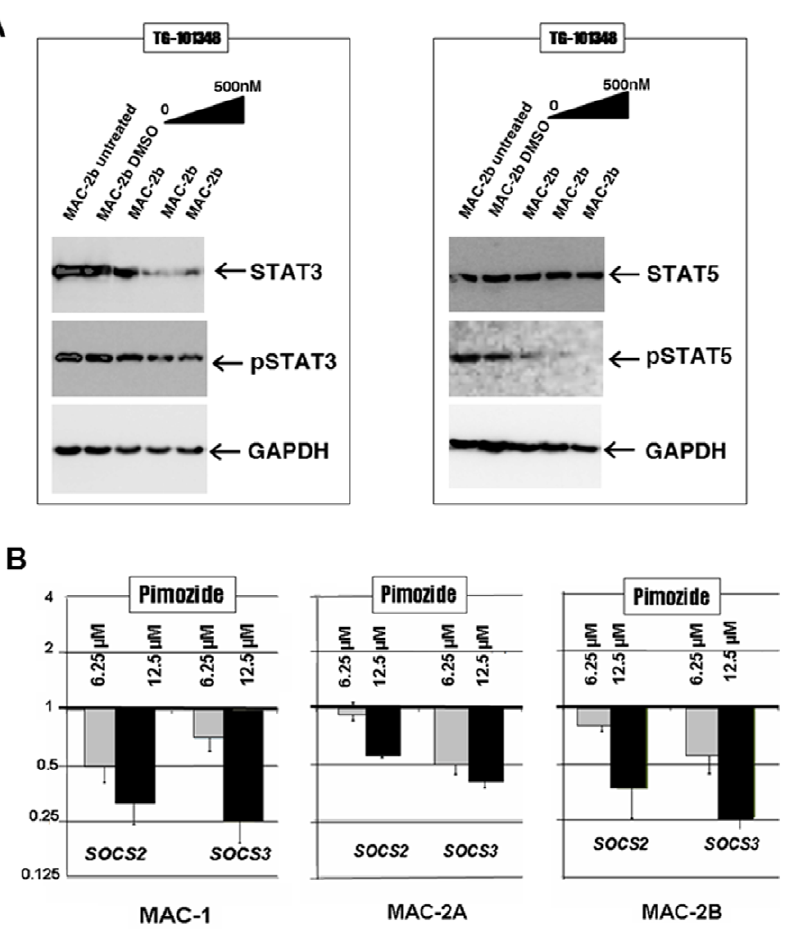
Figure 4. STAT involvement. A: Western blot analysis of STAT3/pSTAT3 and STAT5/pSTAT5 in MAC-2B cells subjected to JAK2 inhibition by exposure to ascending (moderate) concentrations of TG101348 over 72 h. Note dose dependent loss of STAT3 and pSTAT5 only. GAPDH served as loading control. B: Shows expression of SOCS2 and SOCS3 in MAC-1/2A/2B cells exposed to two concentrations of STAT5 inhibitor pimozide for 72 h with vehicle controls set to unity. Note dose dependent losses of SOCS3 expression, followed by SOCS2. Abbreviations: anaplastic large cell lymphoma (ALCL); acute myeloid leukemia (AML); B-lymphoblastoid cell line (B-LCL); cutaneous T-cell lymphoma (CTCL); peripheral T-cell lymphoma (PTCL); T-cell acute lymphoblastic leukemia (T-ALL).